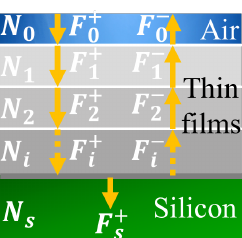
Figure 1. Transmission through thin films, incident and reflected electrical